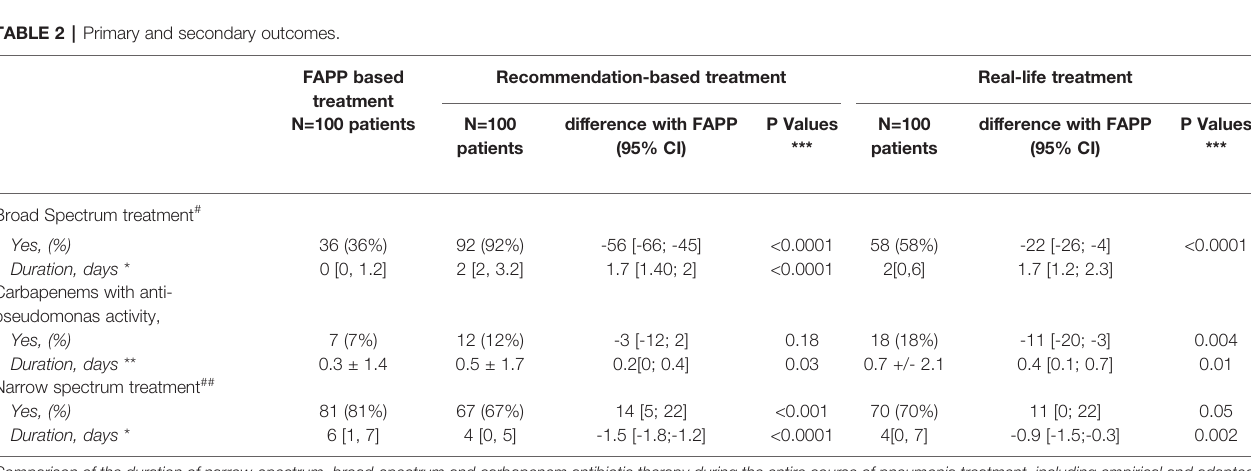
TABLE 2 | Primary and secondary outcomes.